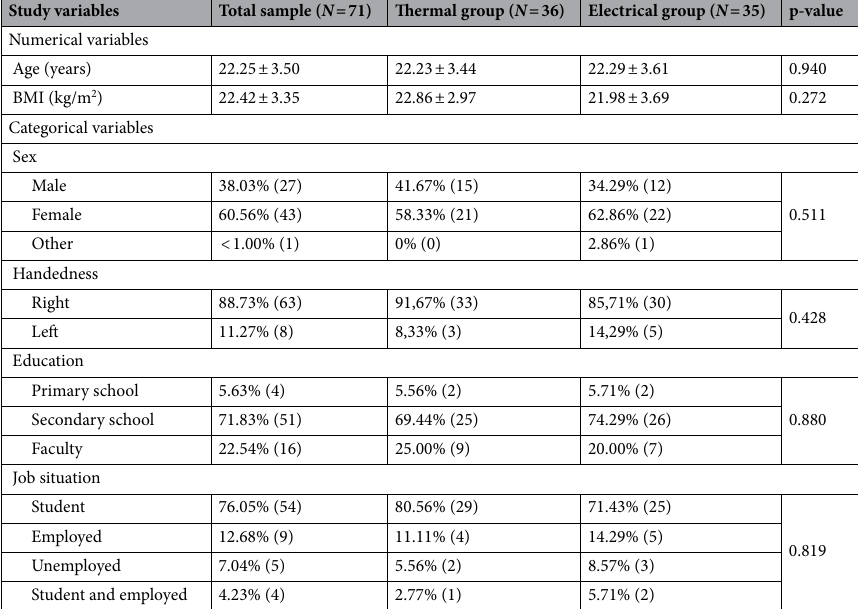
Table 1. Basic descriptive statistics of the study participants, expressed as the mean (± standard deviation) or percentage (number) and p-values of between group analyses.